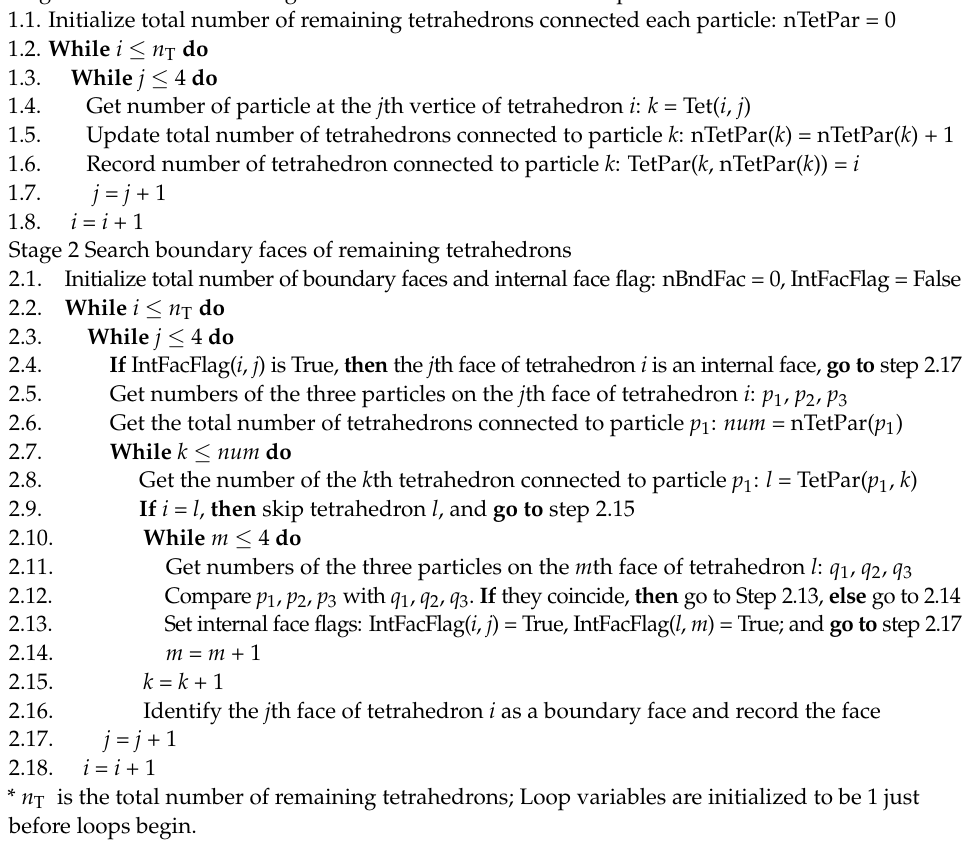
Algorithm 1: Searching of triangular faces on boundaries of remaining tetrahedrons Stage 1 Determine remaining tetrahedrons connected to each